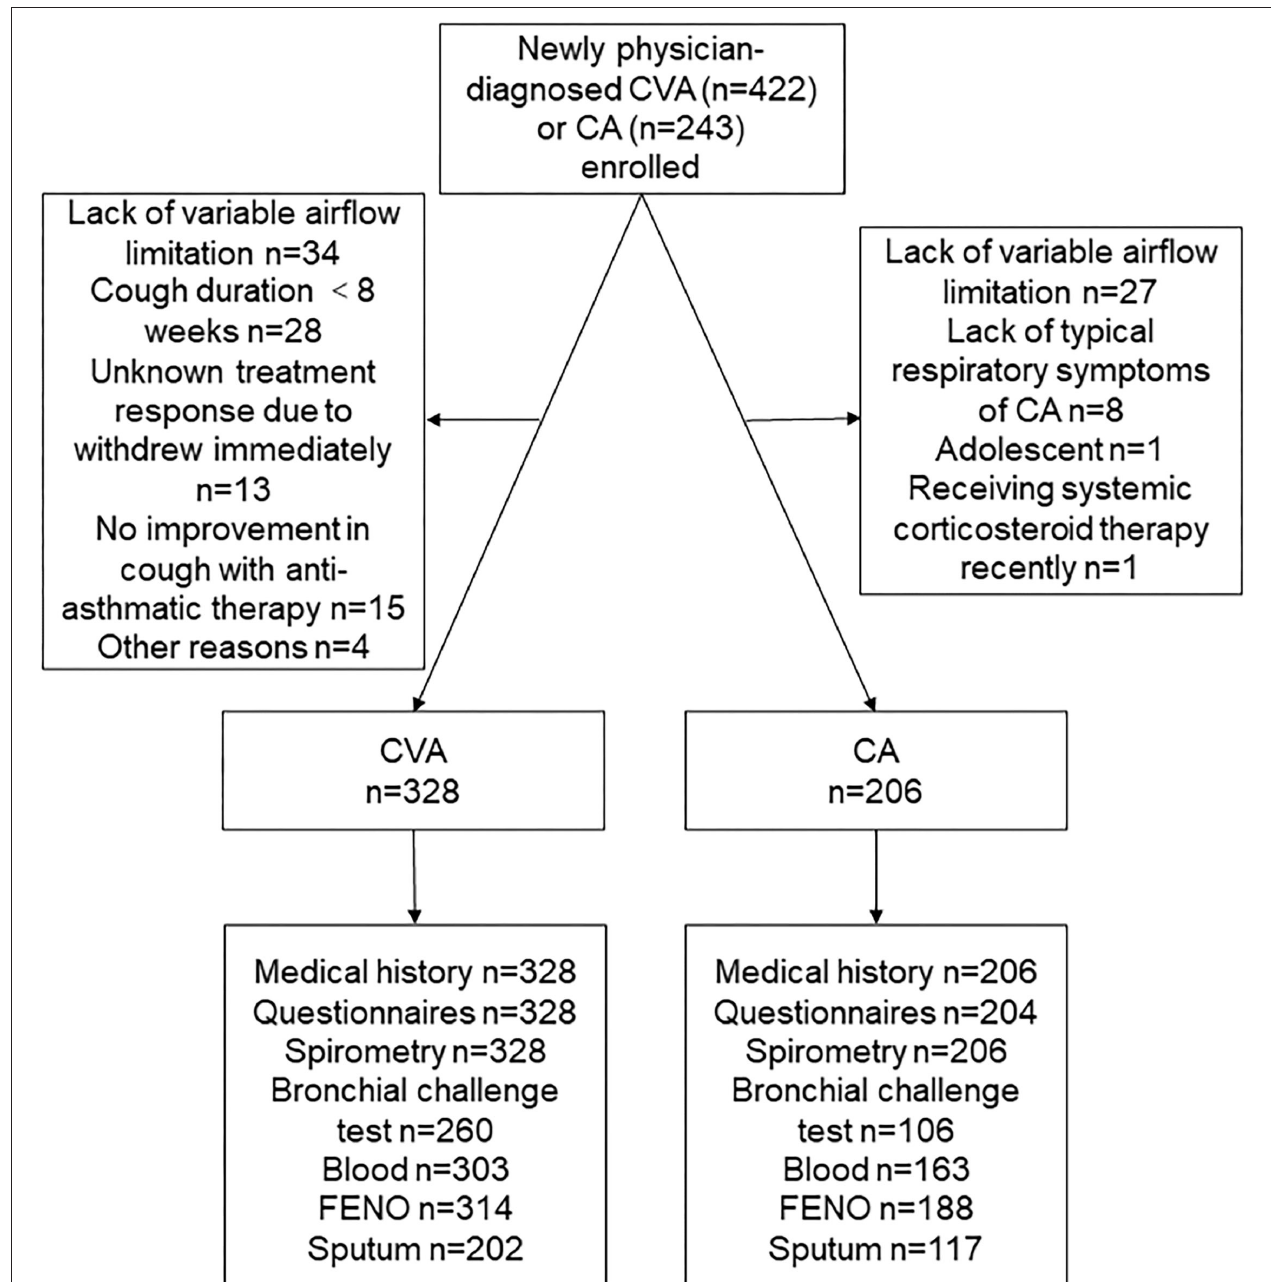
FIGURE 1 | A consort diagram. CVA, cough variant asthma; CA, classic asthma; FENO, fractional exhaled nitric